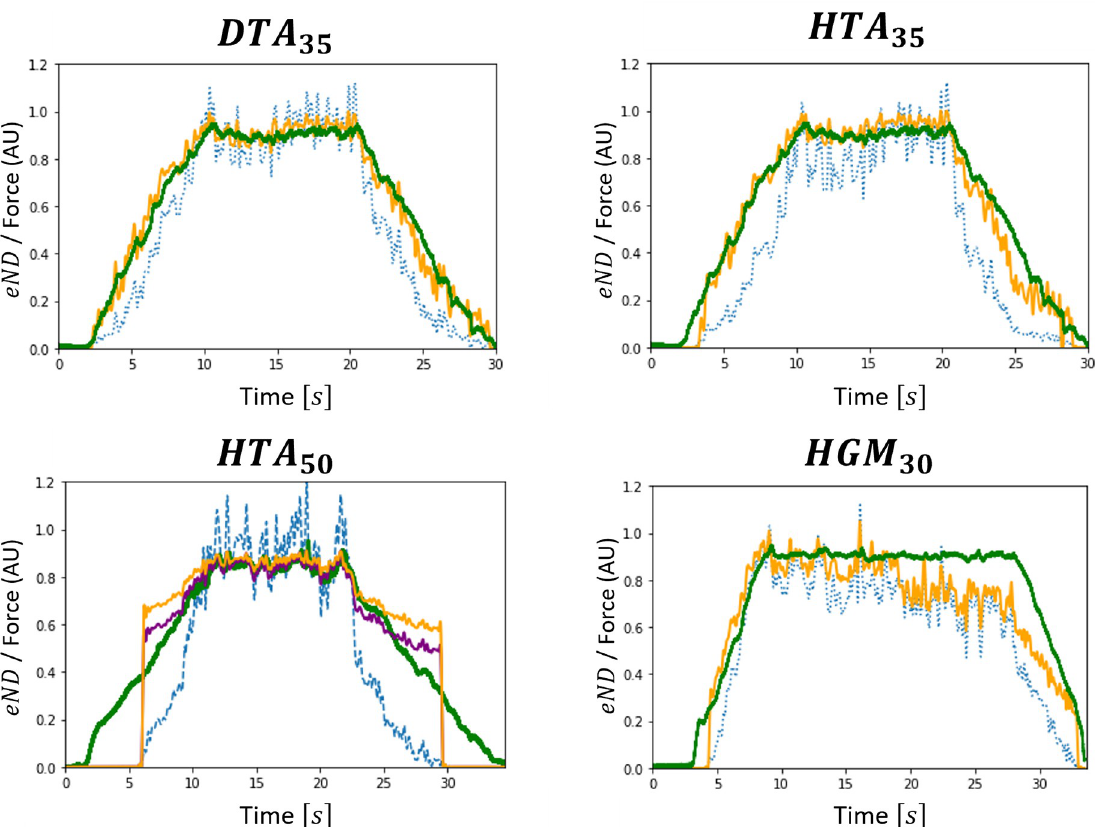
Fig 13. For the 4 datasets, validation against the normalized force trace F ð t Þ (green trace) of the normalized effective neural drive to muscle (eND N ) produced by the complete MN pool (orange trace) and computed from the N MN spike trains sp sim ð t Þ predicted with the j 4-step approach. For comparison, the eND directly computed from the N r identified MNs is also reported (blue dashed trace). For the N r dataset HTA 50 , an additional prediction was performed (purple trace), where the IP(j) distribution obtained from step (3) was updated to return physiological maximum firing rates for all N MNs. https://doi.org/10.1371/journal.pcbi.1010556.g013 obtained from the N simulated spike trains derived in steps (1-4) compared with the experi- mental force F ( t ) with r 2 = 0.95 and nRMSE = 11% for the dataset DTA and r 2 = 0.97 and 35 nRMSE = 11% for the dataset HTA 35 . These results validate the approach provided in this study for predicting the whole muscle force as a collection of MU force contributions from the Table 3. For all four datasets, the r 2 and nRMSE values obtained for the comparison of the time-histories of the normalized experimental force trace against the effective neural drive (1) eND and (2) eND N computed from the N r spike trains of (1) the N identified MNs and (2) the N virtual MNs. The results for HTA 50 (1) were obtained with r the standard approach, while those for HTA 50 (2) were obtained with a revisited IP ( j ) distribution (see text). N r MNs (experimental) N MNs (simulated)